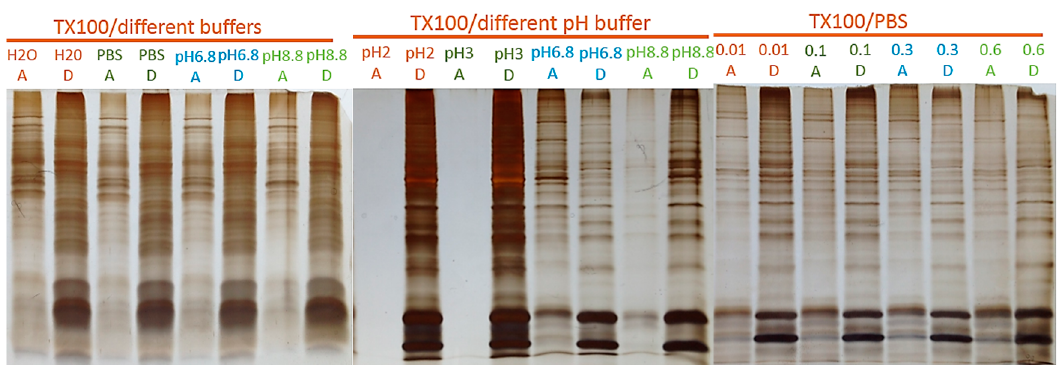
Figure 4. Effects of pH and buffer composition on partitioning of proteins in the detergent and aqueous phases obtained from 4% TX-100/water two-phase separation of a membrane pre-enriched fraction of mouse myeloma cells. A and D stand for aqueous and detergent phases, respectively; pH6.8 and pH8.8 solutions are prepared by Tris buffer (0.5 M) with pH adjusted by HCl; PBS stands for phosphate buffer saline; 0.01, 0.1, 0.3, and 0.6 are the v / v fraction of 1× PBS in system. Figures 4 and 5 show a comparison of cloud point extraction performance using TX-100 vs.